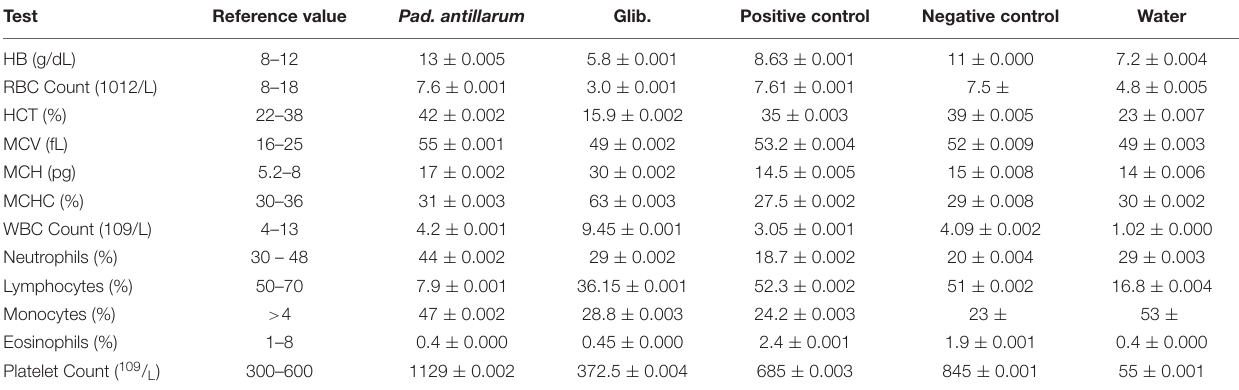
TABLE 6 | Complete blood test of the